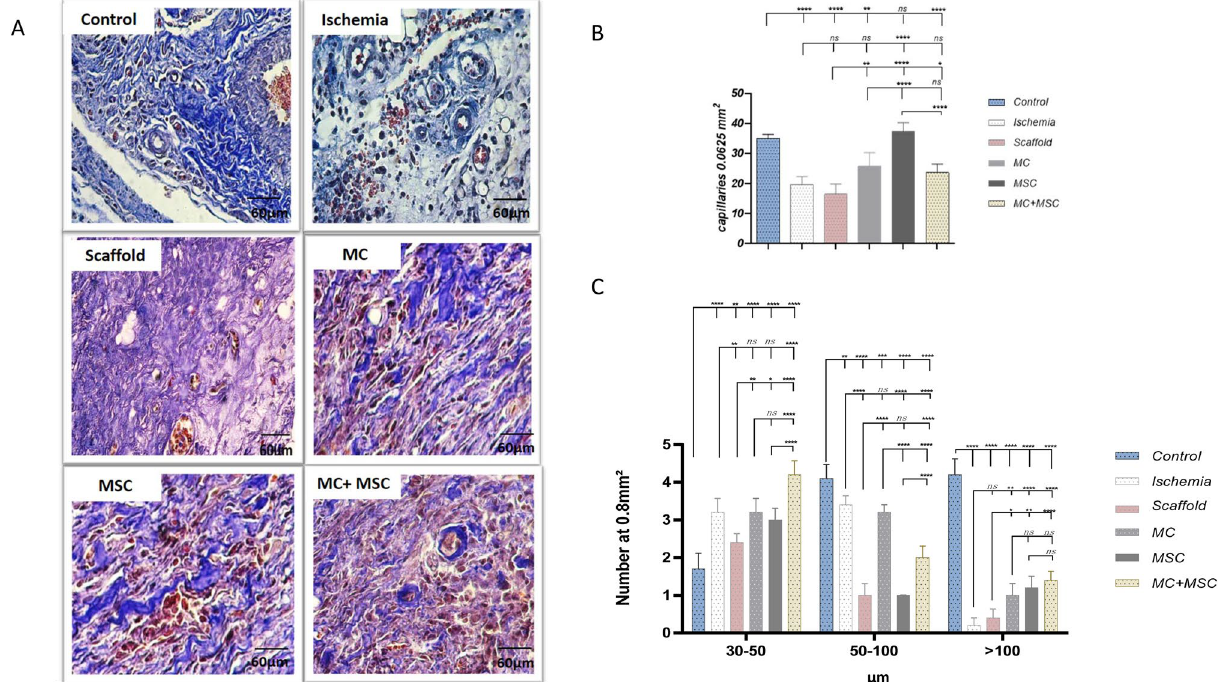
Figure 4. Histomorphometric analysis of capillaries and vessels and qualitative evaluation of angiogenesis in the femoral artery resected area. ( A ) Representative masson trichrome stained sections of the resected area shows increasing angiogenesis in all stem cell treated groups and lack of effect of the hydrogel on angiogenesis. ( B ) Bar graph showing the effect of ischemia on capillary density per 0.0625 mm 2 . ( C ) Histogram showed semi quantitative comparison of blood vessels (intensity and distribution) in femoral artery transected area according to the cross-sectional diameter (30–50, 50–100 and > 100 μm). Data are presented as mean ± SEM of 5 independent experiments. Asterisks indicate statistically significant differences compared to other samples *P ≤ 0.05, **P ≤ 0.01, ***P ≤ 0.001 and ****P ≤